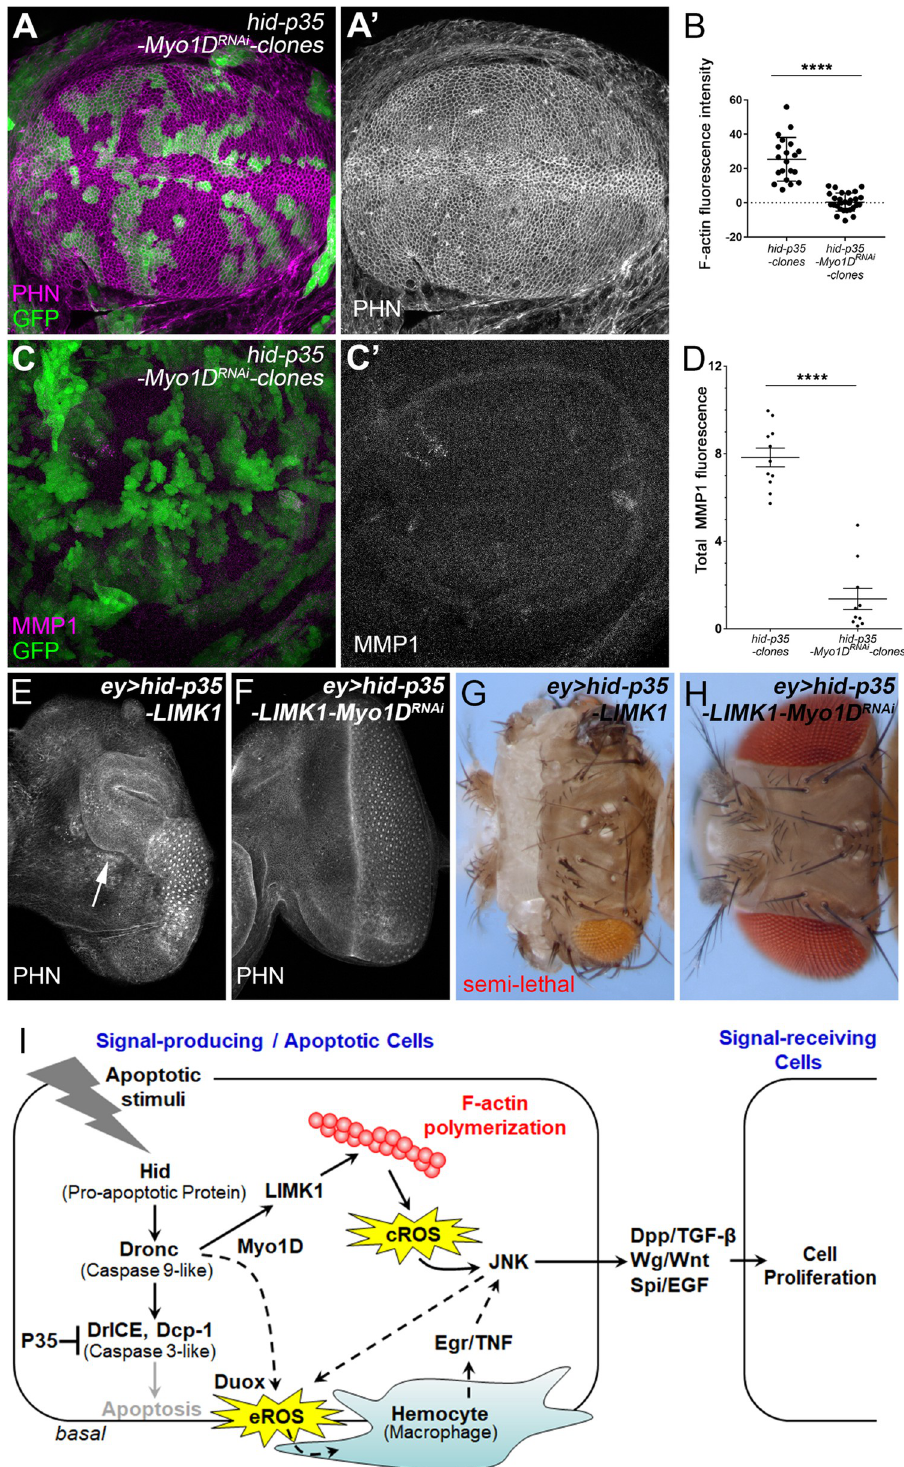
Fig 8. Dronc and LIMK1 drive F-actin polymerization and tissue overgrowth via Myo1D. (A, A’) Apical side images of a late 3 rd instar wing discs with 48-hour old mosaic clones, positively marked by GFP and labelled with PHN (magenta in A and grey in A’). Expression of Myo1D RNAi suppresses F-actin accumulation in hid-p35 clones (compared to Fig 4C and 4C’). (B) Quantification of the F-actin signal intensity in the representative clones of